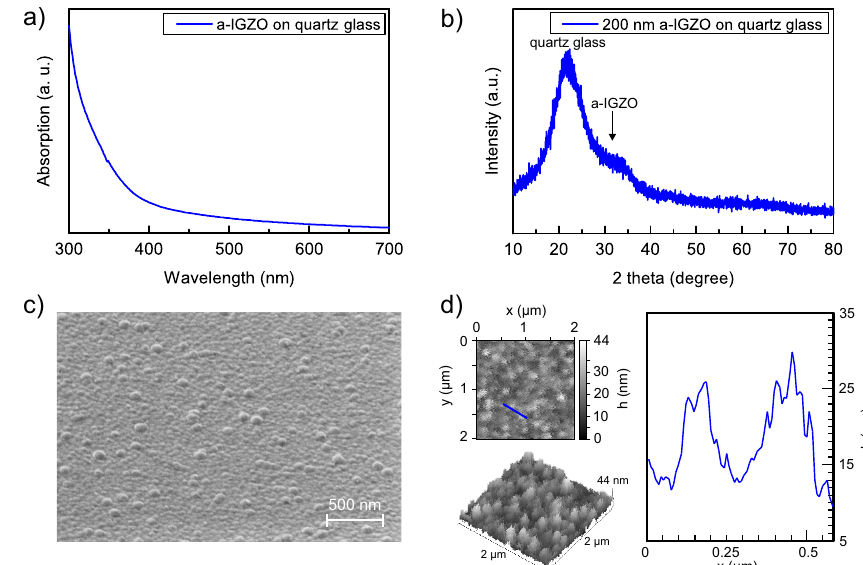
Figure 2. ( a ) ultraviolet-visible (UV-Vis) absorption spectra of 15nm thick a-IGZO and ( b ) X-ray diffraction (XRD) of a 200 nm thick a-IGZO layer, both deposited on quartz glass. ( c ) scanning electron microscopy (SEM) image of the a-IGZO semiconductor layer; ( d ) atomic force microscopy (AFM) of the a-IGZO surface including the 2D and 3D height profile and a representative line profile. SEM and AFM imaging are performed on the fabricated TFT gas